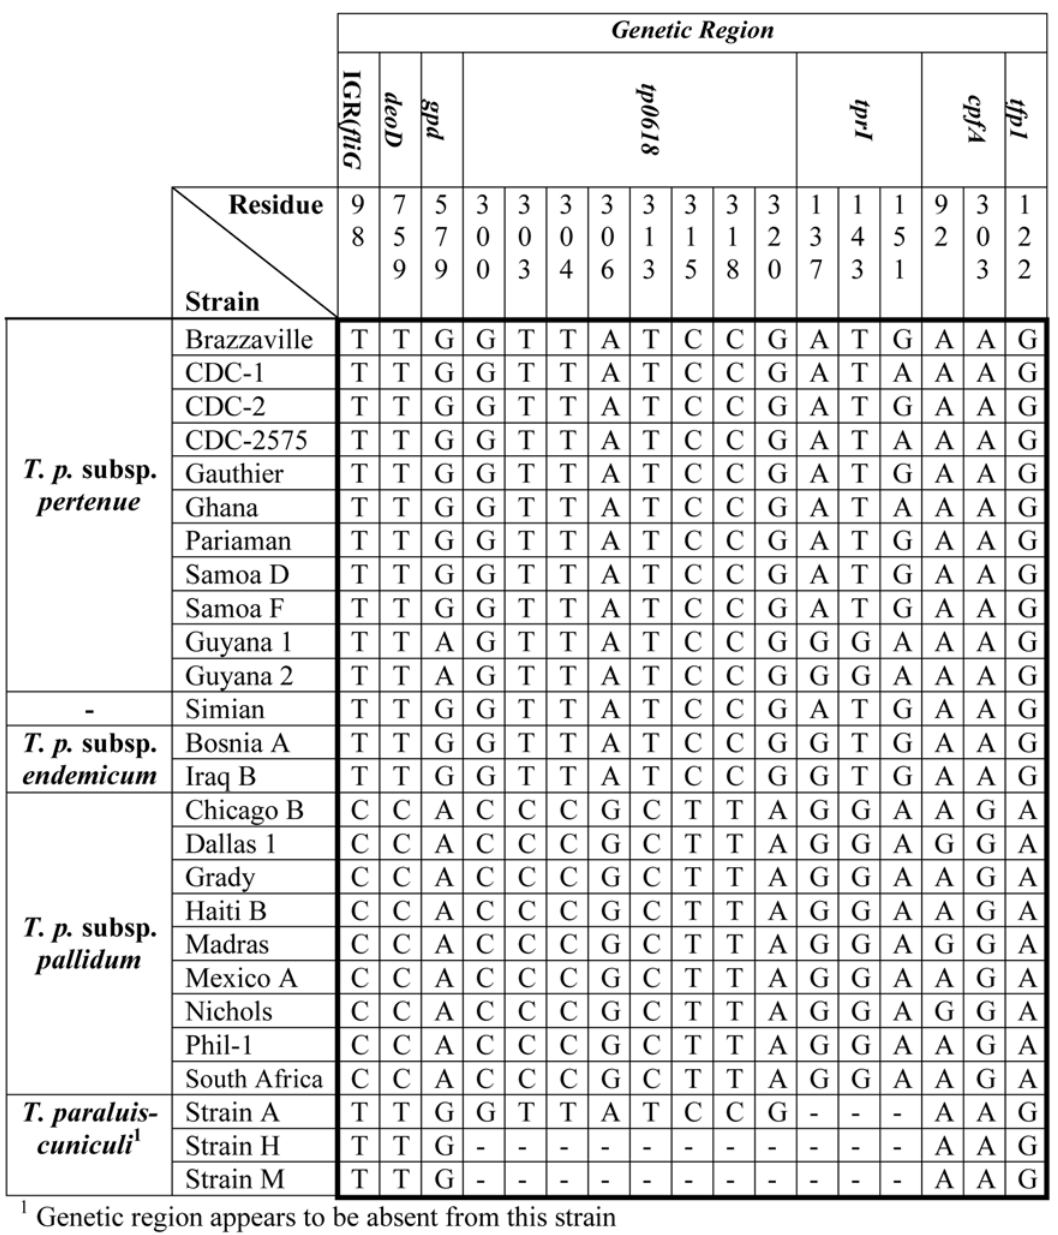
Figure 2. Comparison of 17 single nucleotide polymorphisms present in pathogenic Treponema strains, including 2 strains of T. pallidum subsp. pertenue gathered from